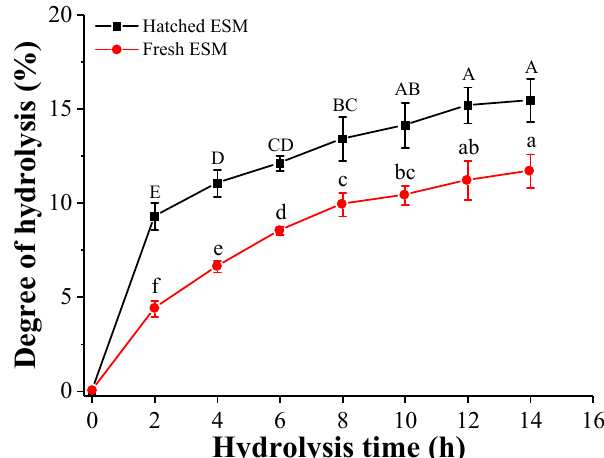
Figure 2. The degree of hydrolysis of the hatched ESM ( ■ ) and fresh ESM ( ● ) hydrolyzed under the same enzymatic hydrolysis condition. Values are expressed as mean ± SD ( n = 3). Different letters in the hydrolysis kinetic curve of hatched ESM (A–E) and fresh ESM (a–f) indicate significant differences ( p < 0.05).